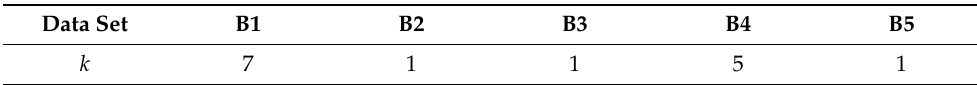
Table 6. Value of k for each data